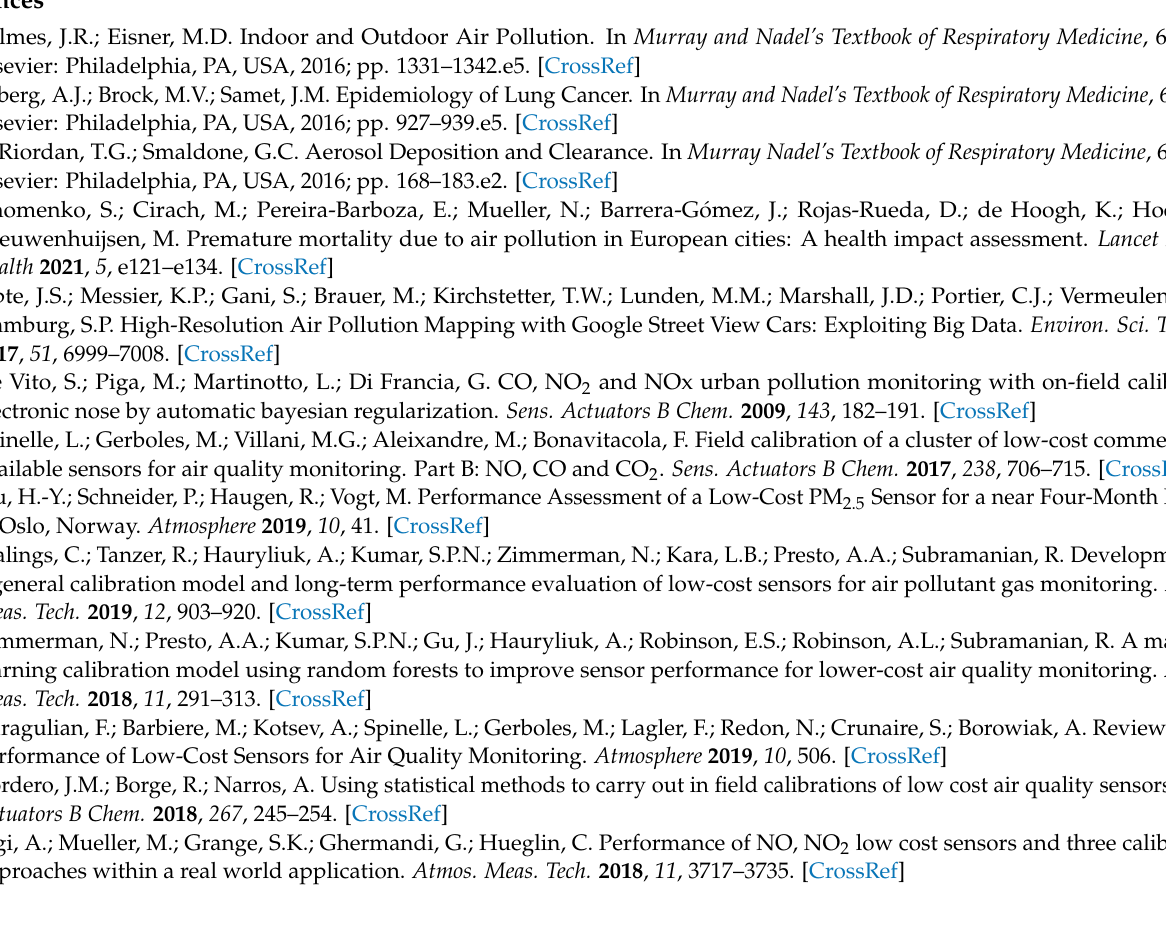
device 2. (b) Fraction of anomalies (weekly moving average) over four months for different ν across algorithms after two weeks of field calibration for sensor data of device 3. Figure S3: (a) Fraction of anomalies (monthly moving average) over a year for different ν across algorithms after two weeks of field calibration for sensor data. (b) Fraction of anomalies (monthly moving average) over a year for different ν across algorithms after two weeks of field calibration for reference data. Figure S4: Calibration results for one randomly sampled device (exposure to 10,000 uniformly sampled gas concentrations). Calibration distribution, i.e., distribution of the target gases, is uniform and so are sensor signals, though with two exceptions. For low fractions of NO 2 (CO: 0–400 ppb, NO 2 : 0–15 ppb, O 3 : 0–150 ppb), the NO 2 -B4 signal is composed of normally distributed noise. For high fractions of NO 2 (CO: 0–400 ppb, NO 2 : 0–150 ppb, O 3 : 0–150 ppb), the signal of the OX-B4 sensor becomes triangularly distributed. Figure S5: (a) Trajectories of sensor signals at lower concentrations of target gases (CO: 50 ppb, NO 2 : 50 ppb, O 3 : 50 ppb) for a randomly sampled device; drift of baseline is clearly visible. (b) Trajectory of sensor signals at higher concentrations of target gases (CO: 600 ppb, NO 2 : 600 ppb, O 3 : 600 ppb) for a randomly sampled device; drift of sensitivity is visible and causes some curvature of the